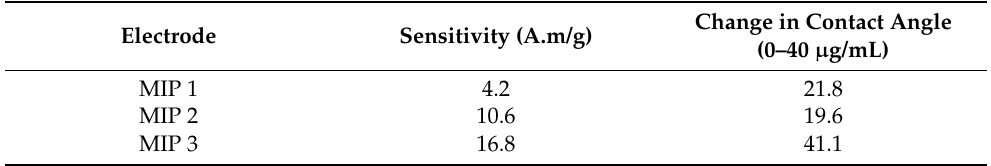
Table 1. Response of the three types of